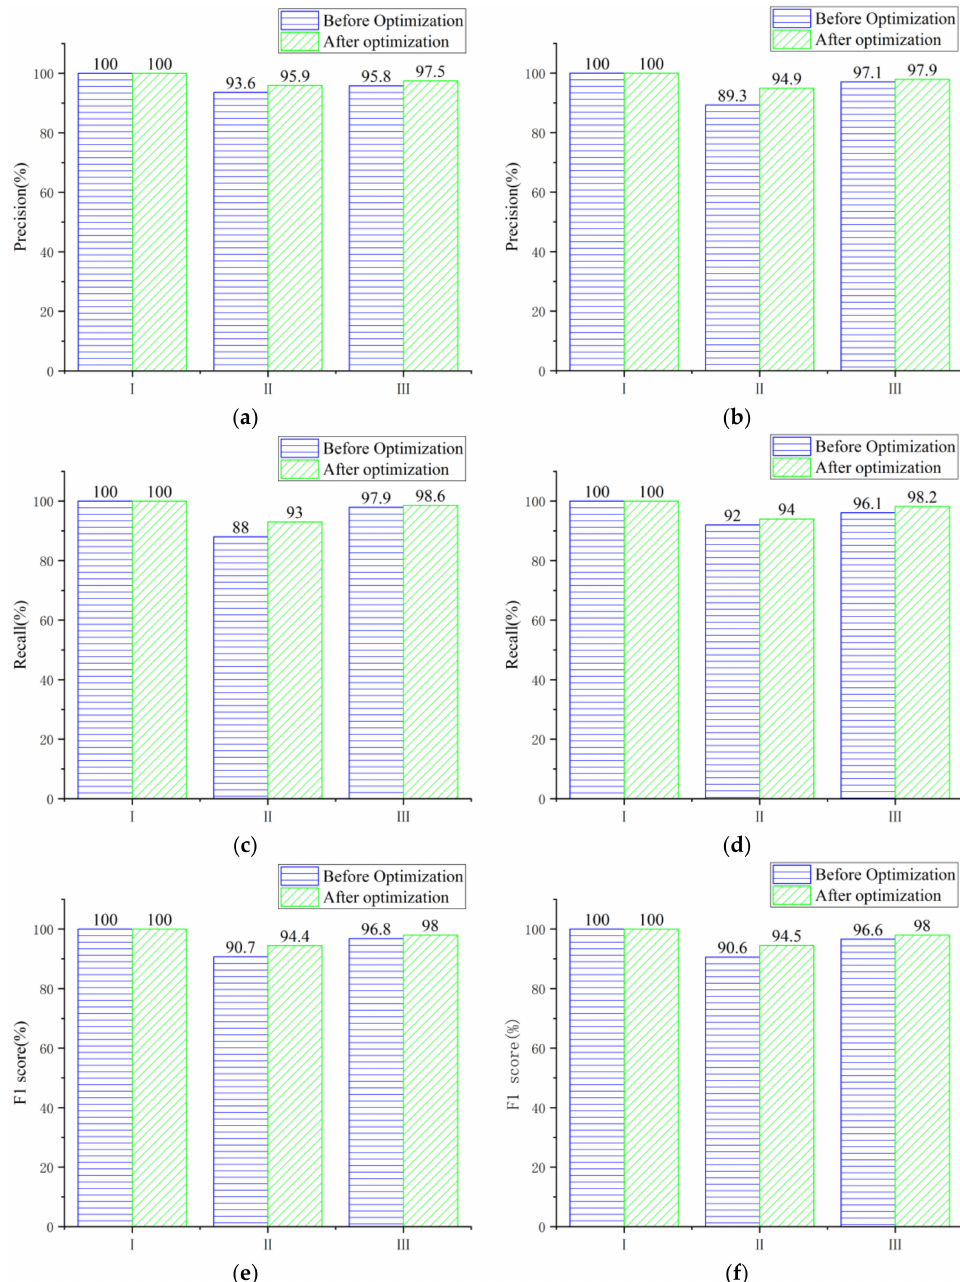
Figure 6. Comparison of test samples’ evaluation indexes before and after optimization: ( a ) Precision-